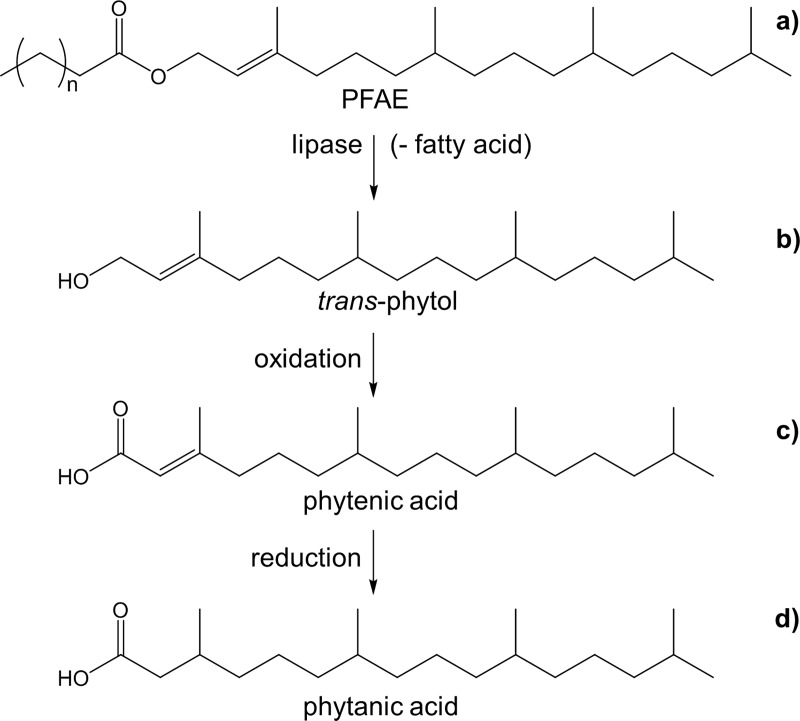
Schematic metabolism of PFAE in the human body with cleavage of PFAE (a) into the free fatty acid and free trans-phytol (b), which is then further metabolized by oxidation into phytenic acid (c) and finally by reduction of the double bond into phytanic acid (d) [6,30].